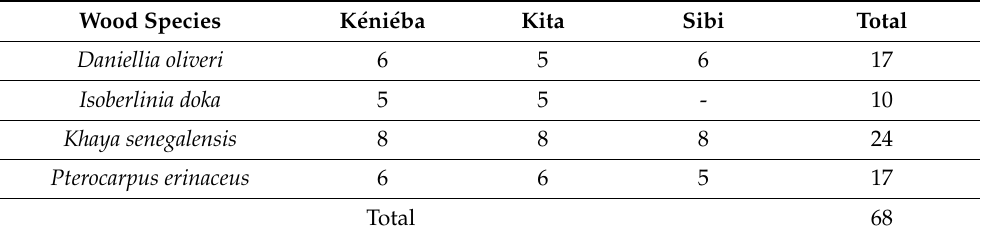
Table 1. Total number of samples (per species and area) analyzed using CIELab and FTIR-ATR. Wood Species K é ni é ba Kita Sibi Total Daniellia oliveri 6 5 6 17 Isoberlinia doka 5 5 - 10 Khaya senegalensis 8 8 8 24 Pterocarpus erinaceus 6 6 5 17 Total